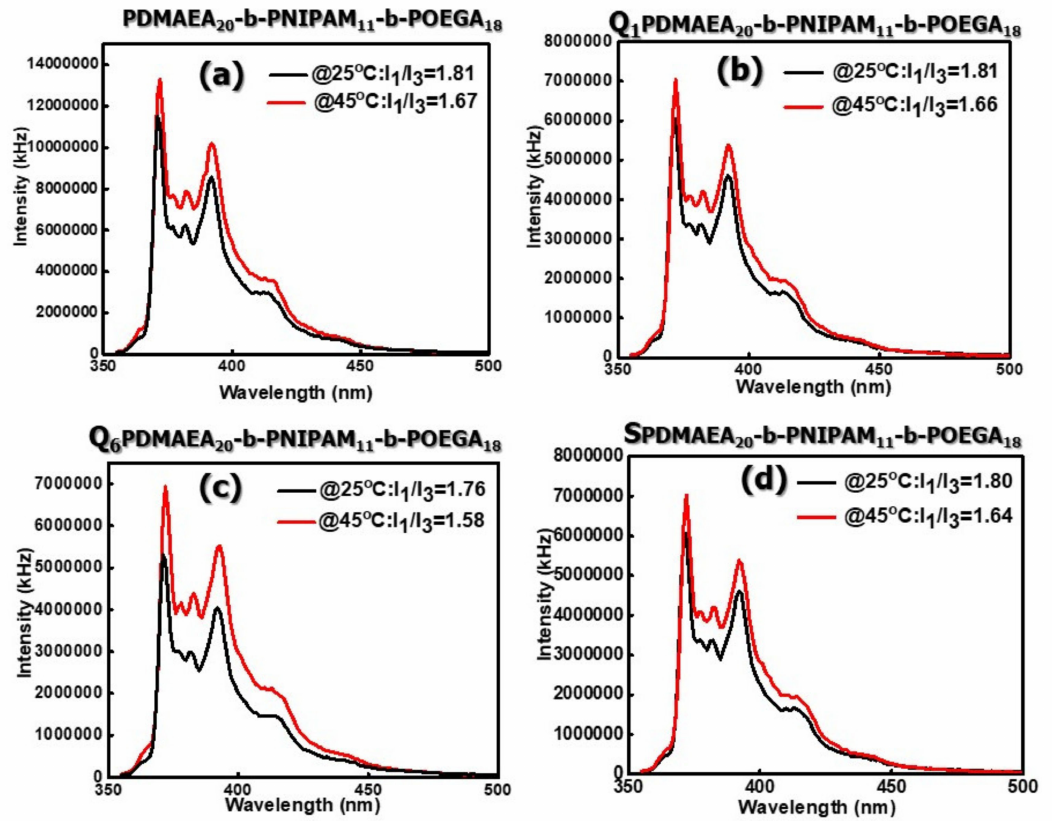
Figure 8. Fluorescence spectra for PDMAEA 20 -b-PNIPAM 11 -b-POEGA 18 ( a ), Q 1 PDMAEA 20